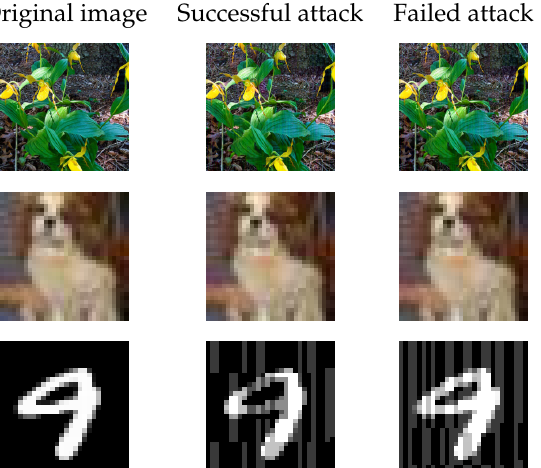
Figure 1. Examples of adversarial attacks generated by QuEry Attack. With higher resolution the attack becomes less visible to the naked eye. The differences between images that successfully attack the model and those that do not are subtle. ( Top row ): Imagenet ( l ∞ = 6/255). ( Middle row ): CIFAR10 ( l ∞ = 6/255). ( Bottom row ): MNIST ( l ∞ = 60/255). ( Left ): the original image. ( Middle ): a successful attack. ( Right ): A failed